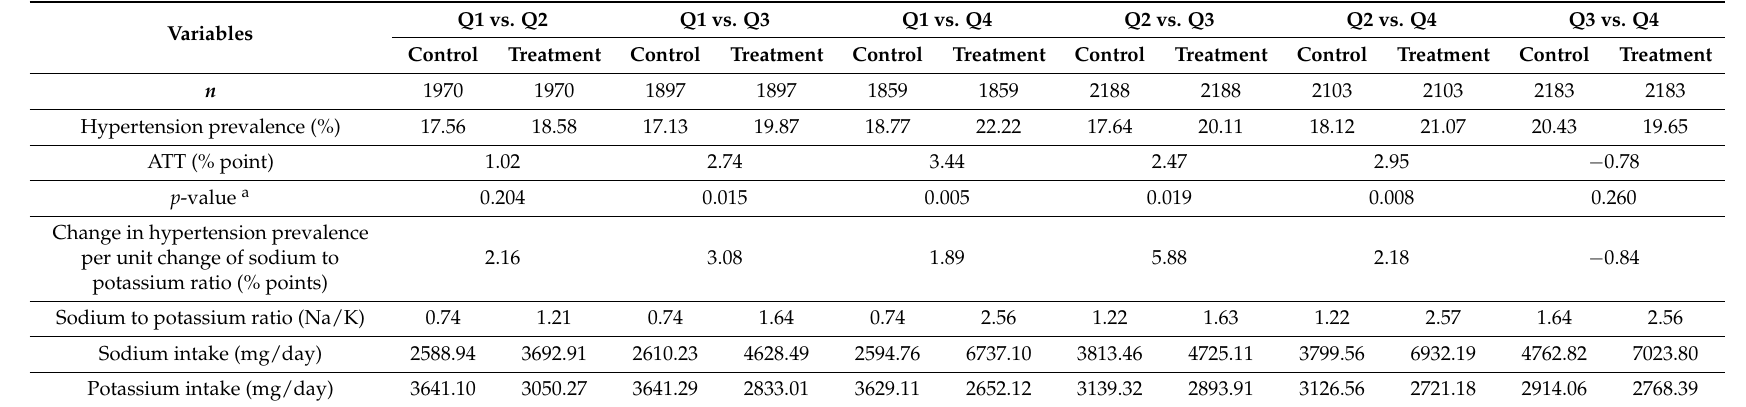
Table 3. Average treatment effects (ATT) of the sodium to potassium ratio on hypertension prevalence and nutrition intake for six pairwise comparisons using propensity score